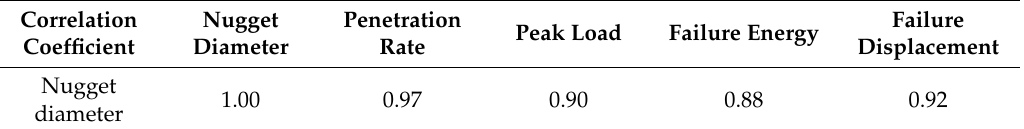
Table 5. Correlation coefficients of the five welding quality